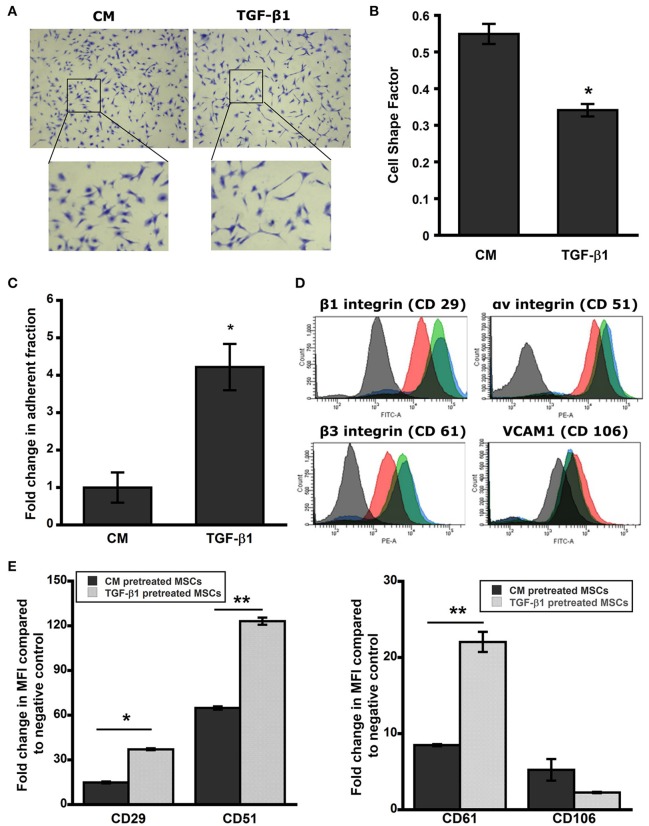
Pretreated MSC maintain elongated phenotype. (A) Brightfield images of pretreated MSCs after 24 h stained with crystal violet. TGF-β1 pretreated MSCs sustained elongated morphology in serum free media for a period of 24 h. (B) Cell shape factor (CSF) was determined by analysis of bright field images with Image J. CSF was used to characterize the elongation of the cell, with a shape factor of 1 indicating a perfect circle and 0 indicating a straight line. Results are reported as average ± s.e.m. (n = 2). (C) The centrifuge-based adhesion assay was used to determine the effect of soluble factor pretreatment on the adhesion of MSCs on uncoated surface. (D) TGF-β1 pretreated MSCs maintain surface adhesion characteristics. Histograms from flow cytometry were analyzed using FACS-DIVA for mean fluorescence intensity (MFI). Expressions of surface integrins αv (CD51), β1 (CD 29), and β3 (CD61) were increased significantly in TGF-β1 pretreated cells compared to the control; whereas TGF-β1 pretreatment reduced VCAM1 (CD106) expression significantly compared to the control. (E) Analysis of cell surface adhesion molecules αv (CD51-PE), β1 (CD29-FITC), and β3 (CD61-PE) integrins, and VCAM-1 (CD106-FITC) using flow cytometry after 24 h of removal of stimulus. Black and red indicates negative and control cell population; whereas green and blue represent TGF-β1 pretreated cells at immediately (t0) and 24 h (t0 + 24 h) after the removal of stimulus respectively. TGF-β1 pretreated cells exhibit higher integrin expression and lower VCAM-1 expression at 24 h after removal of the stimulus compared to control cells. Results are reported as average. (n = 2). Values given as mean ± s.e.m.; significance is indicated as *(p < 0.05), **(p < 0.005).